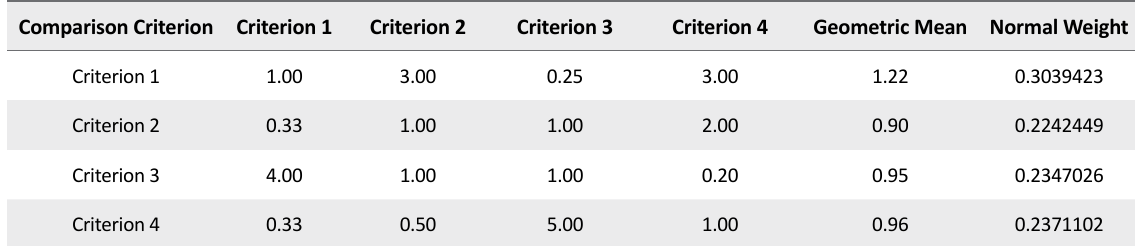
Table 2. Pairwise comparison matrix of criteria of four research models Comparison Criterion Criterion